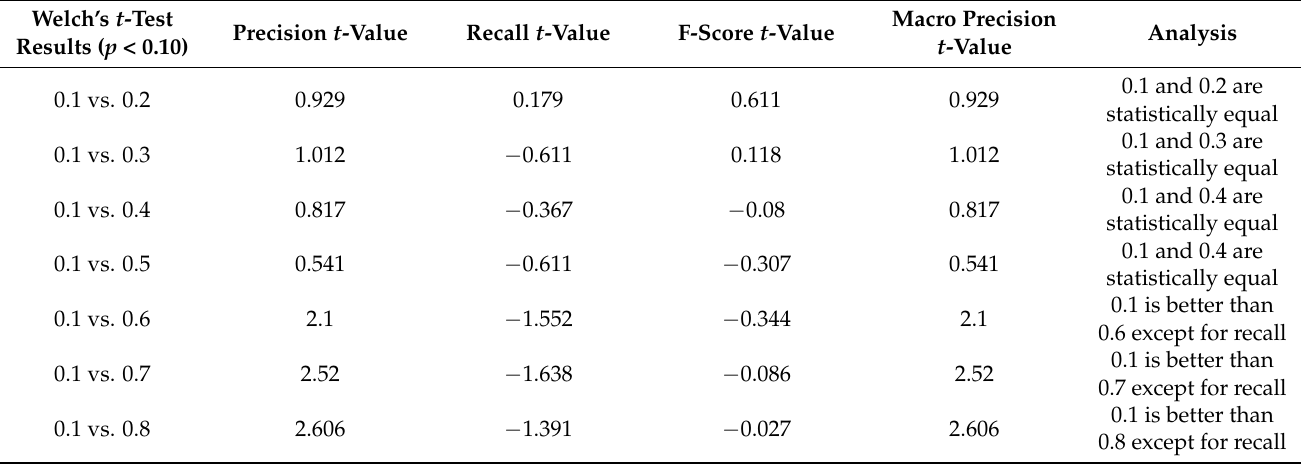
Table 24. Welch’s t -test results: UWF-ZeekData22: privilege escalation—random undersampling after